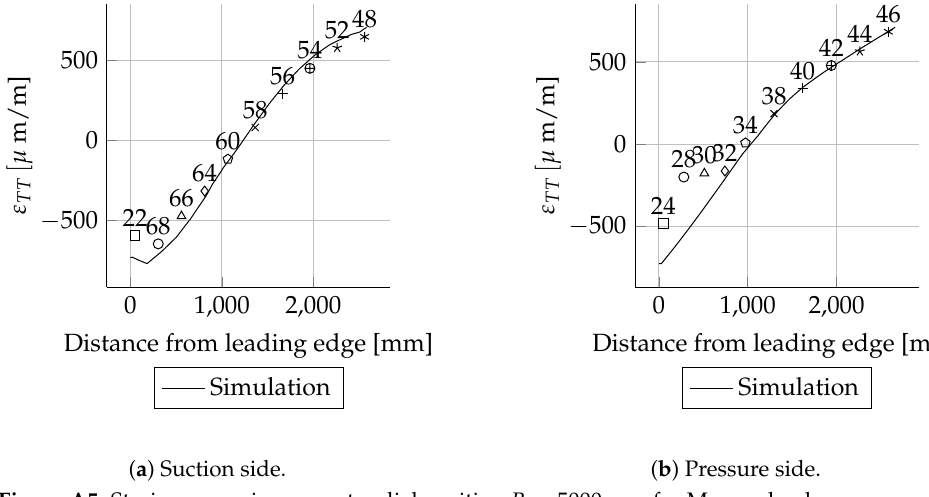
Figure A5. Strain comparison ε LL at radial position R = 5000 mm for Mxmax load